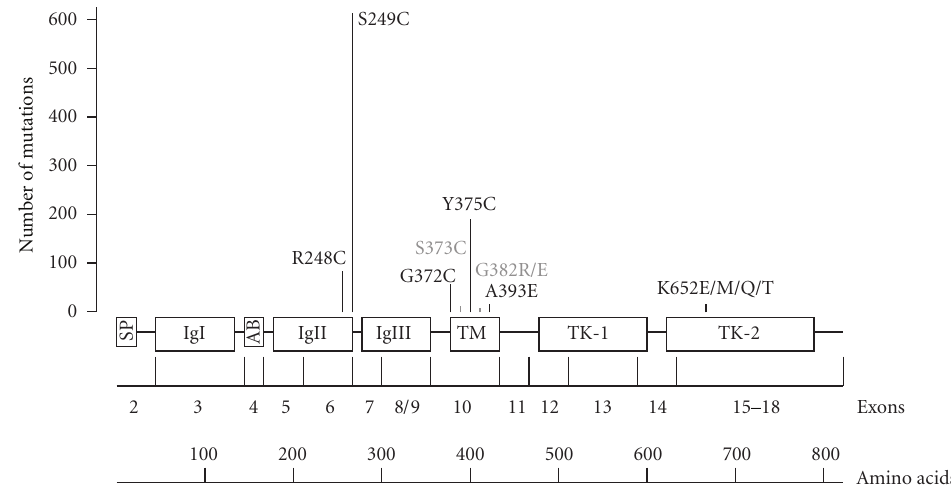
Figure 1: Schematic representation of human FGFR3 protein and corresponding FGFR3 coding exons. Exon numbering based on Tomlinson et al. [38]. Type and total number of reported mutations are based on data pooled from 11 studies [25–29, 31, 32, 39–42], including a total of 1898 bladder tumours. SP: signal peptide; IgI–III: immunoglobulin-like domain; AB: acid box; TM: transmembrane domain; TK; tyrosine- kinase